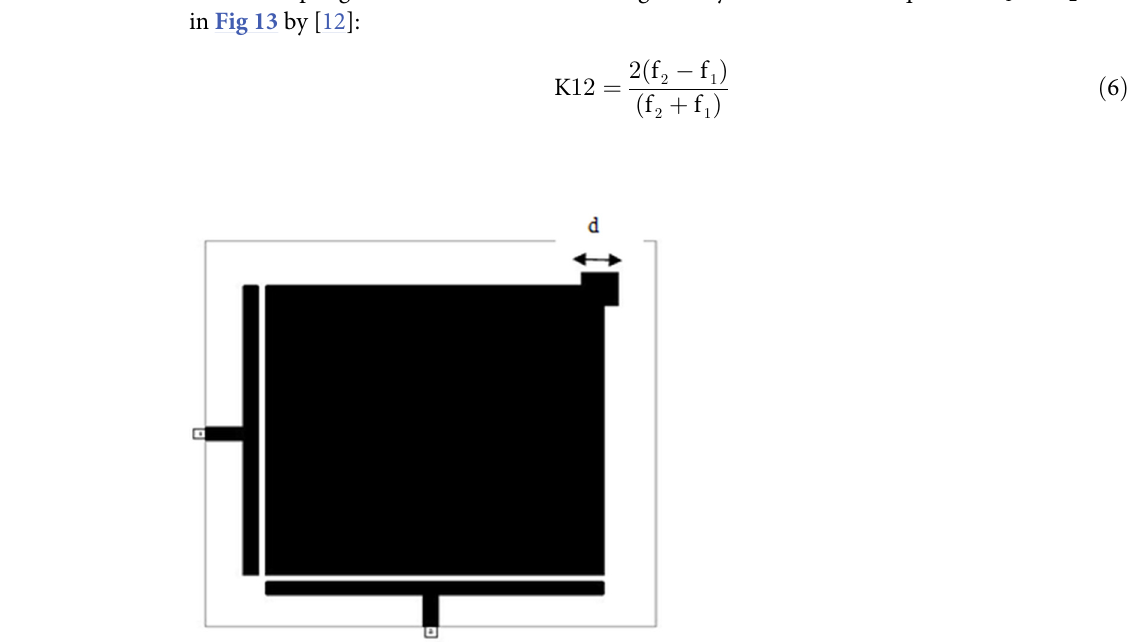
Fig 9. The layout of the modeled dual-mode conventional patch